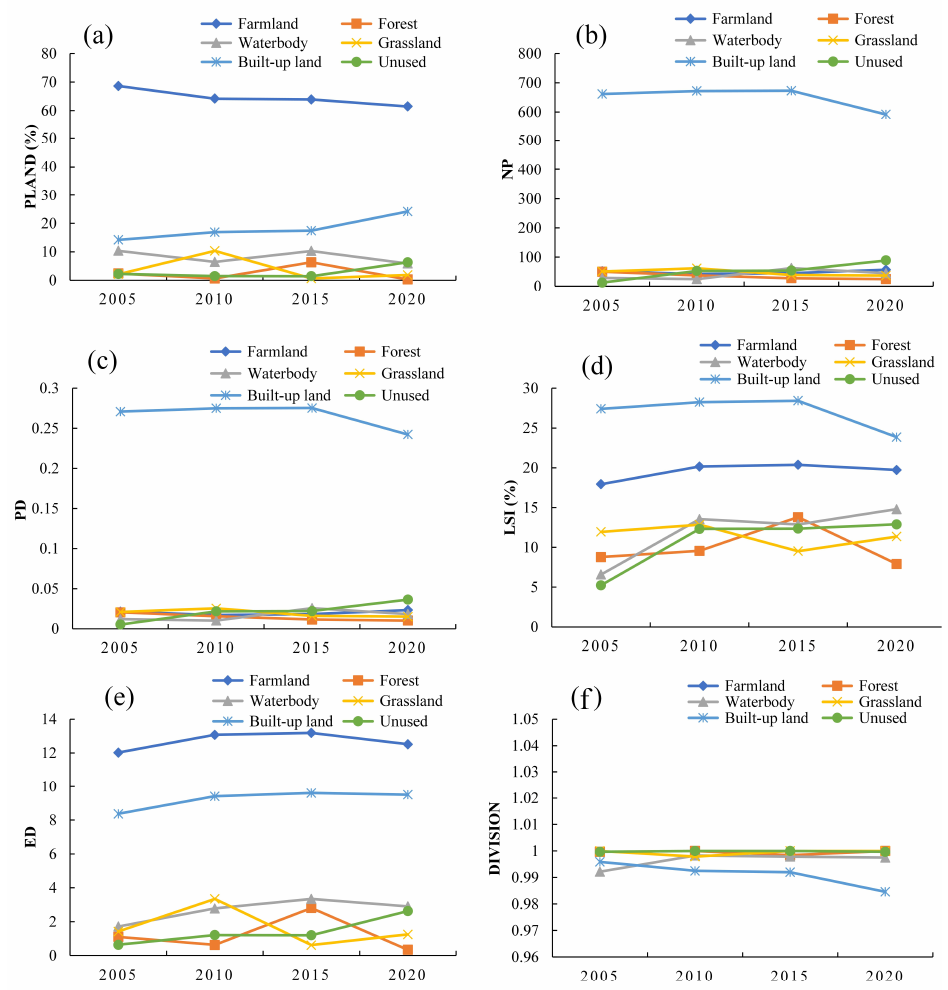
Figure 6. Changes in landscape pattern metrics of ( a ) PLAND; ( b ) NP; ( c ) PD; ( d ) LSI; ( e ) ED; ( f ) DIVISION from 2005 to 2020.